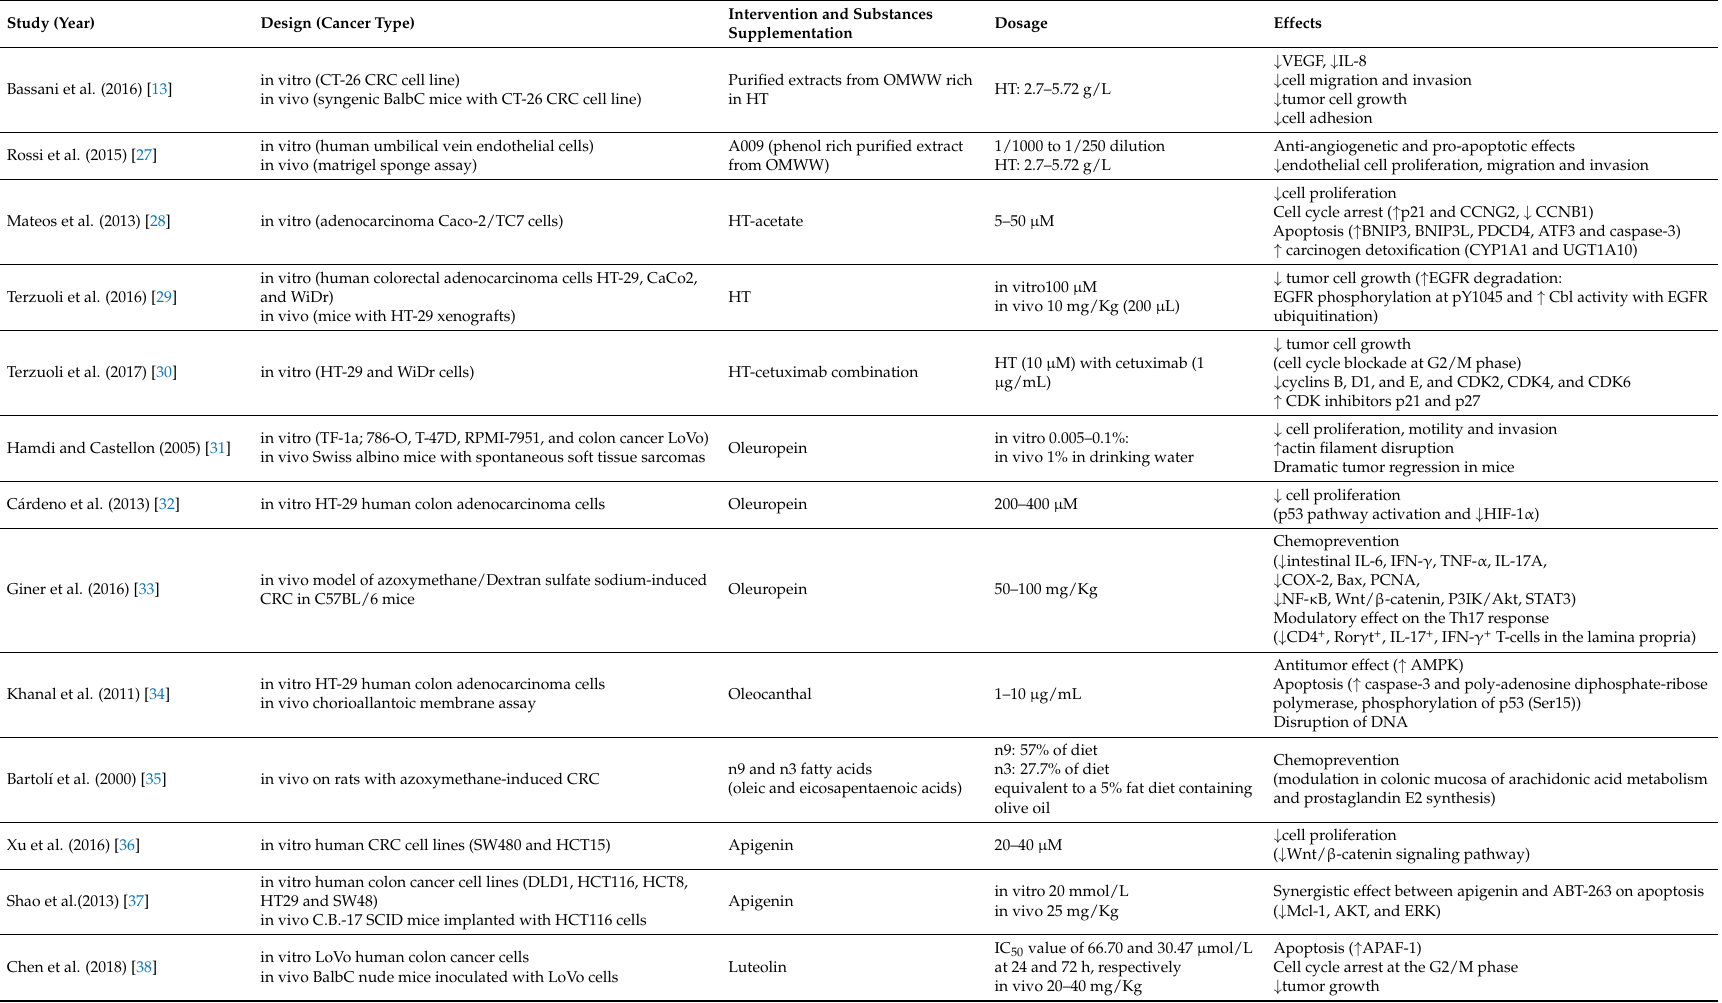
Table 1. Principal intervention studies on the effects of olive oil substances on colorectal